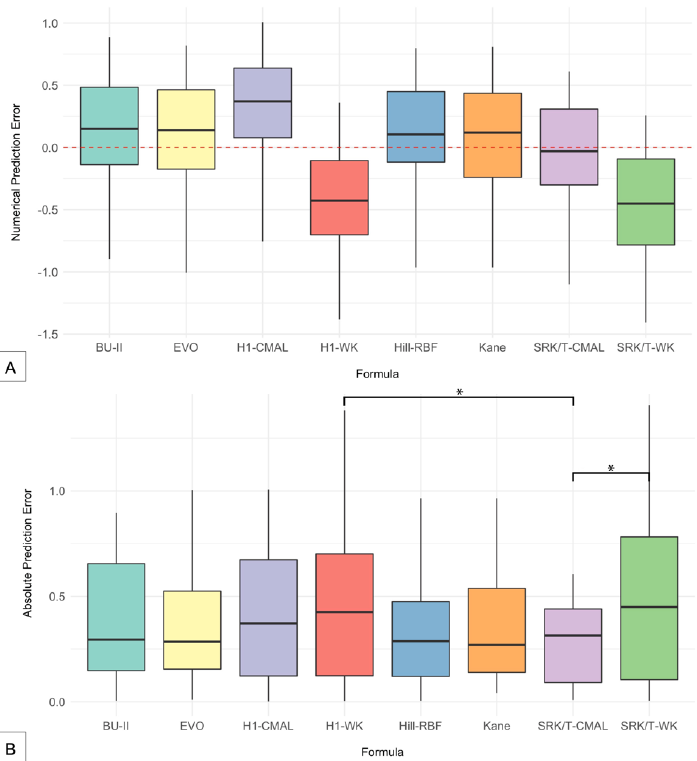
Figure 1. Boxplots showing the prediction errors of intraocular lens calculation formulas. ( A ) The numerical prediction errors were calculated by subtracting the predicted spherical equivalent (SE) from the postoperative SE. ( B ) The absolute prediction errors were then taken from the numerical prediction errors. BU-II = Barrett Universal II; CMAL = Cooke-modified axial length; EVO = Emmetropia Verifying Optical; H1 = Holladay 1; WK = Wang–Koch AL adjustment. * significant p < 0.05.